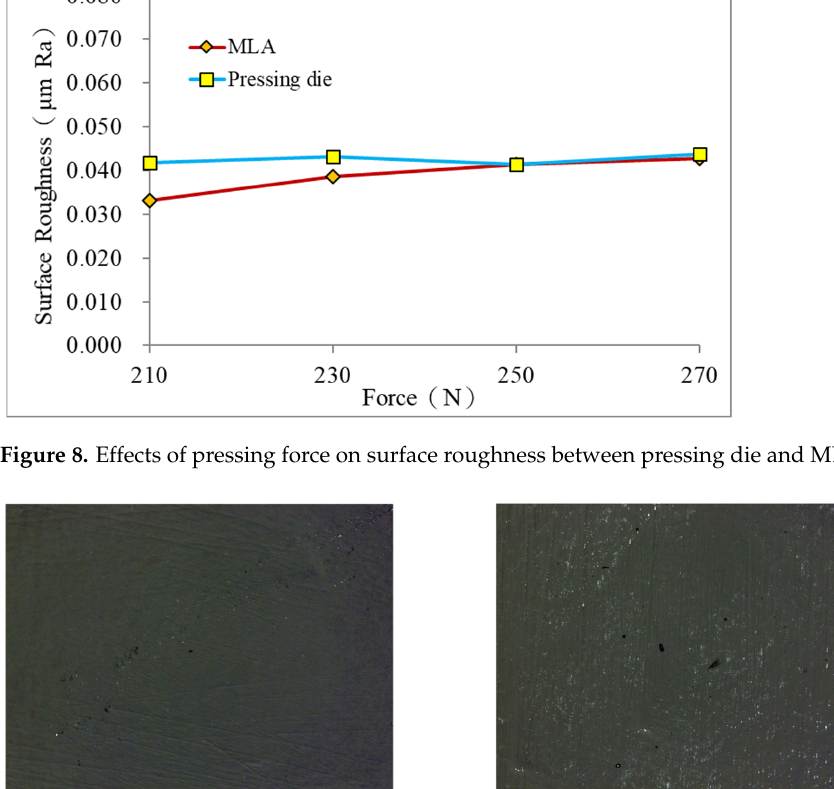
Figure 7. SEM diagrams at different molding temperature: ( a ) 680 °C; ( b ) 690 °C.